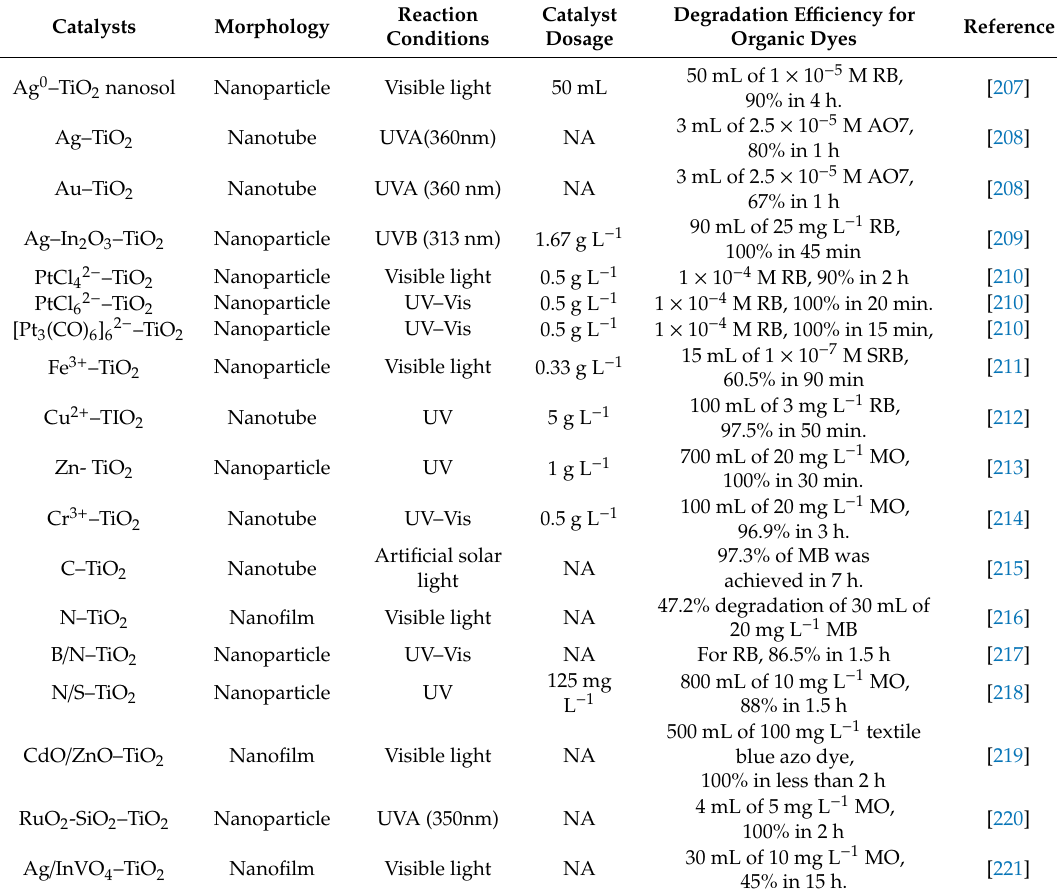
Table 2. Summary of common methods to improve TiO 2 photocatalytic dye degradation